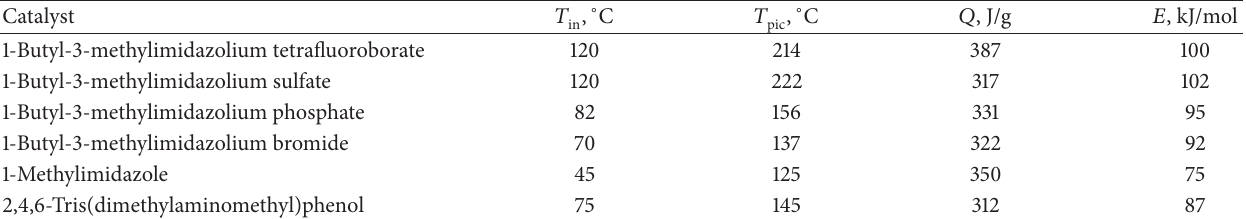
Table 1: Kinetics parameters of interaction reaction of ED-20 resin and IMTHPA under the action of 1-butyl-3-methyl imidazolium salts with various inorganic anions in molecule, of 1-methyl imidazole and of 2,4,6-tris(dimethylaminomethyl)phenol. Catalyst 𝑇 , ∘ C in